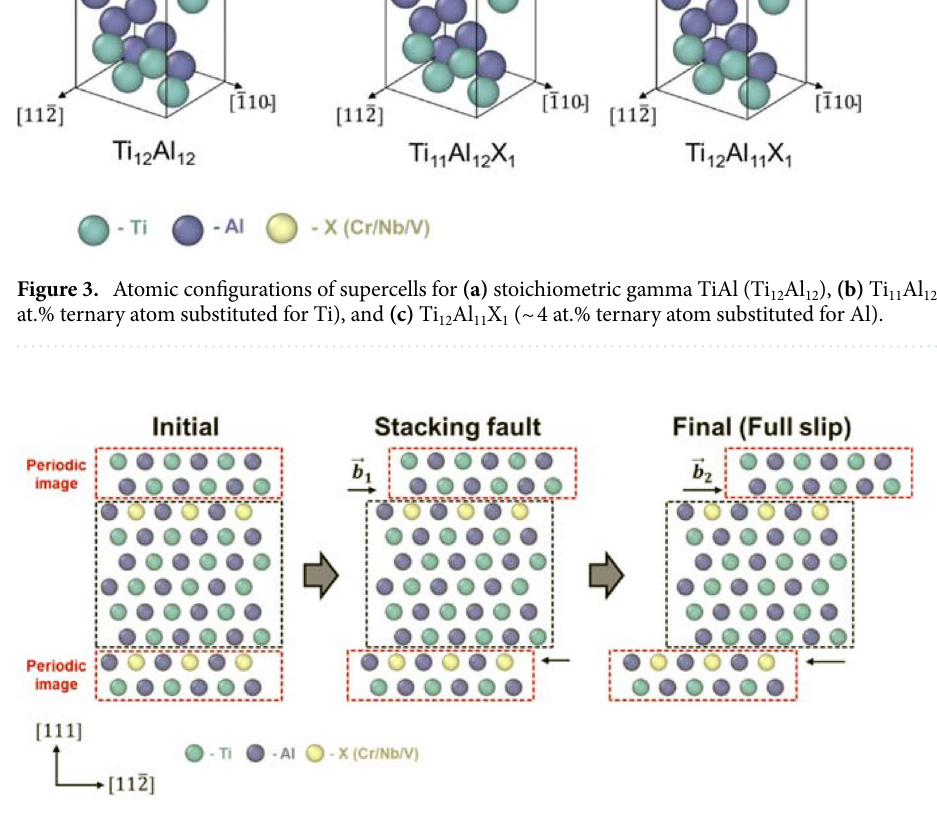
Figure 4. Stacking faults model for GSFE